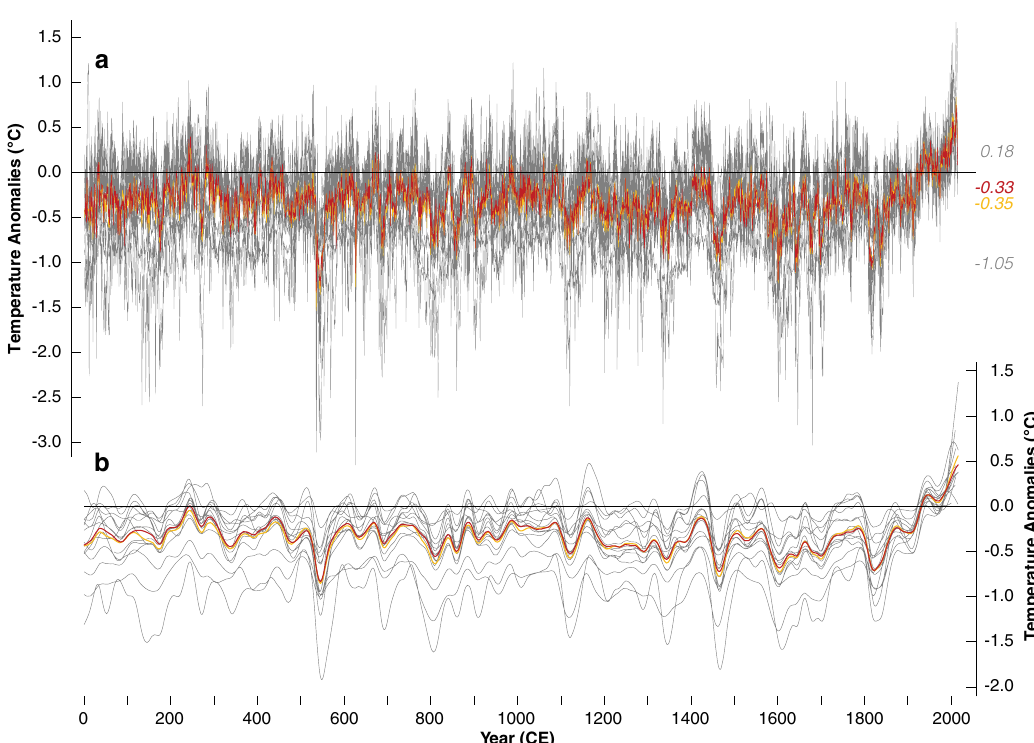
Fig. 4 Temperature reconstructions. a Ensemble of 15 reconstructions (grey lines), together with their mean and median (orange and red). Numbers on the right refer to the long-term mean of the maximum, and minimum, as well as mean and median values between 1 and 2016 CE. The mean and median correlate signi fi cantly at 0.98 ( p < 0.0001) and exhibit similar fi rst-order autocorrelation coef fi cients of 0.71 and 0.70, respectively. b The 15 ensemble reconstructions and their mean and median after applying 50-year cubic smoothing spline